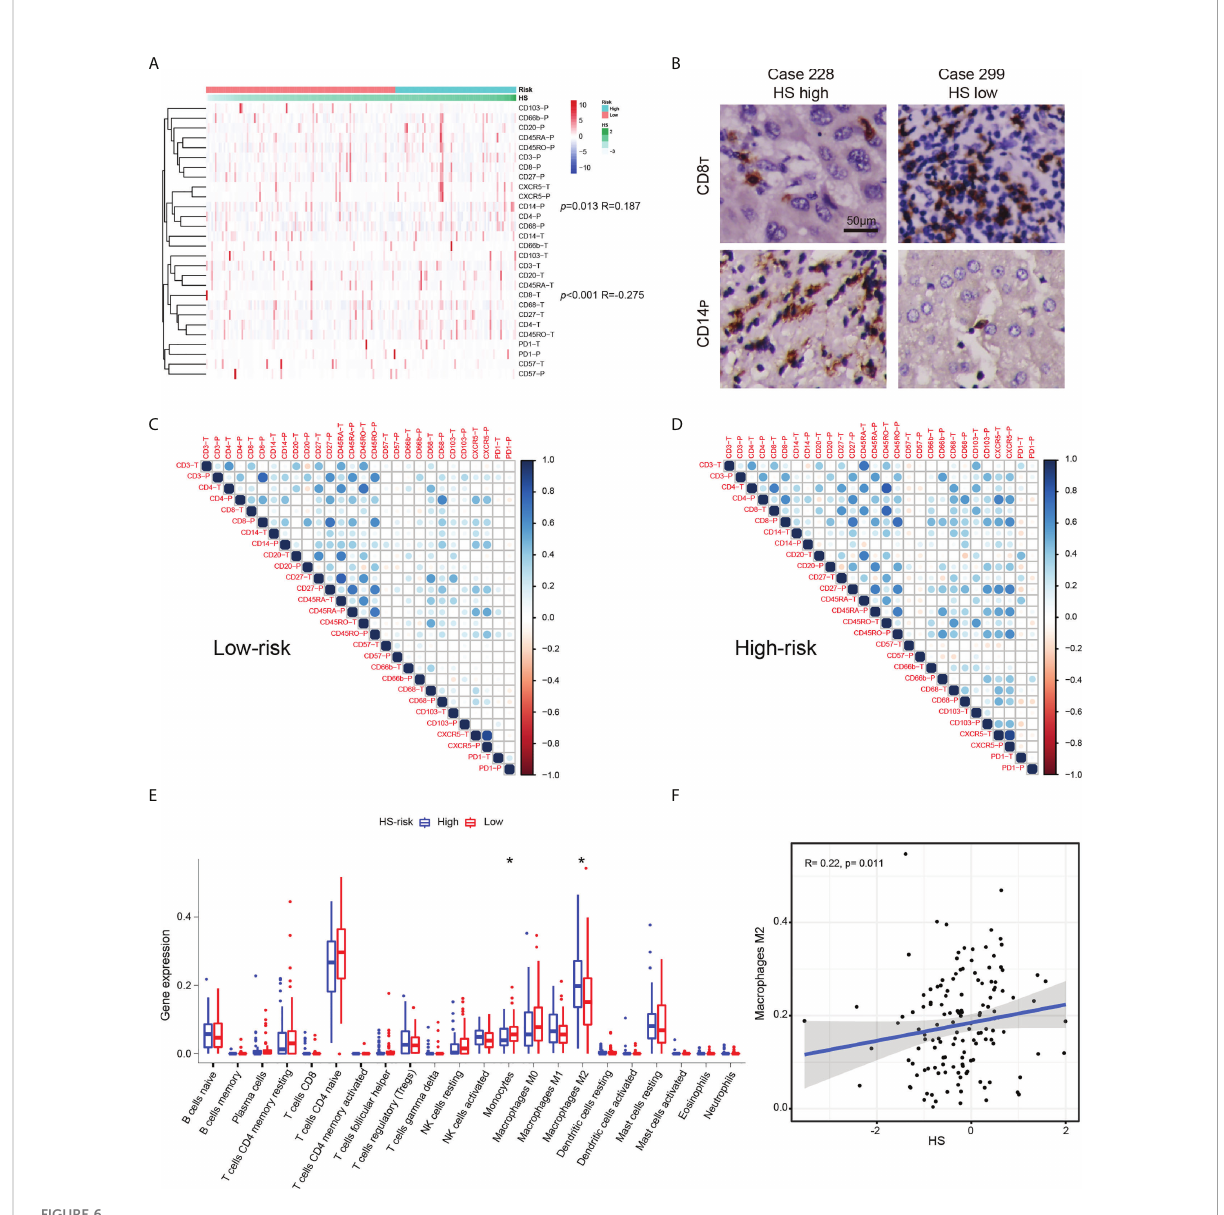
FIGURE 6 The relationship between HS and immune in fi ltration condition. (A) Heatmap and cluster analysis of the Zhongshan TMA. (B) Typical immunohistochemical pictures of CD8 T AND CD14 P . (C) The corrplots of immune markers in the HS low-risk group. (D) The interaction analysis of immune markers in the HS high-risk group. (E) Boxplot of immune cells in the TCGA cohort. Data are compared using Wilcoxon test. *p < 0.05;. (F) Correlation analysis between HS and M2macrophages in the TCGA cohort. HS, histological score; TCGA, The Cancer Genome